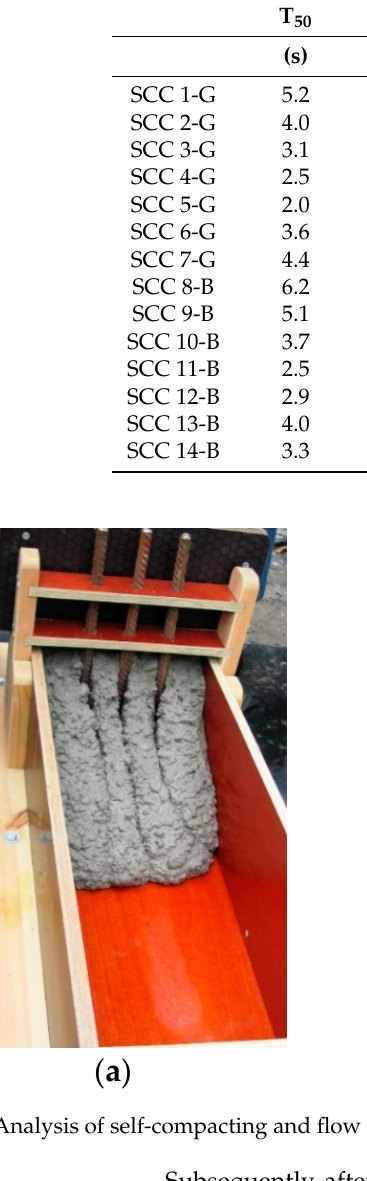
Table 16. Juxtaposition of the results of analyses of the rheological features of concrete mixes.